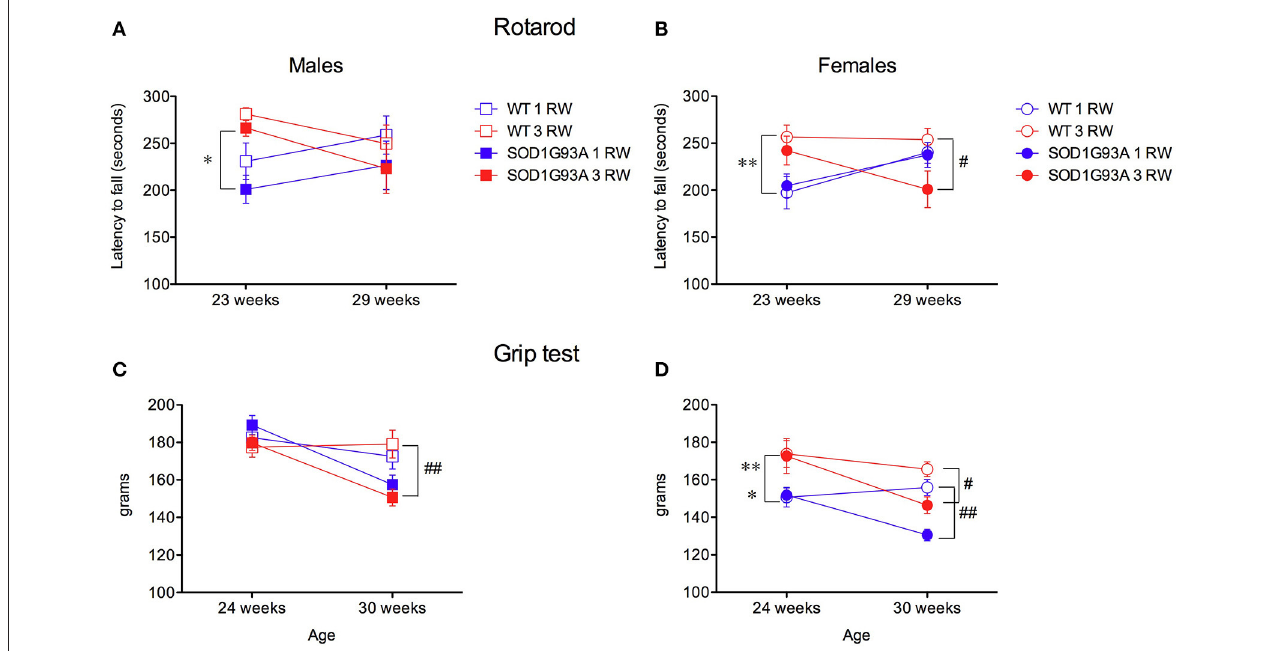
FIGURE 6 | Effect of exercise experience on Rotarod and Grip strength tests. (A,B) Rotarod test. Latency to fall (seconds, mean ± s.e.m. of 3 trials/4 days) from rod in male and female mice at age 23 and 29 weeks. Bonferroni post-hoc tests: * P < 0.05, ** P < 0.01 1 RW vs. 3 RW; # P < 0.05 WT vs. SOD1G93A. (C–D) Grip strength test (grams, 4 paws mean ± s.e.m. of 5 trials) in male and female mice at age 24 and 30 weeks. Bonferroni post-hoc tests: * P < 0.05 1 RW vs. 3 RW in SOD1G93A, ** P < 0.01 1 RW vs. 3 RW in WT; # P < 0.05 WT vs. SOD1G93A in 3 RW, ## P < 0.01 WT vs. SOD1G93A in 3 RW males and in 1 RW females.